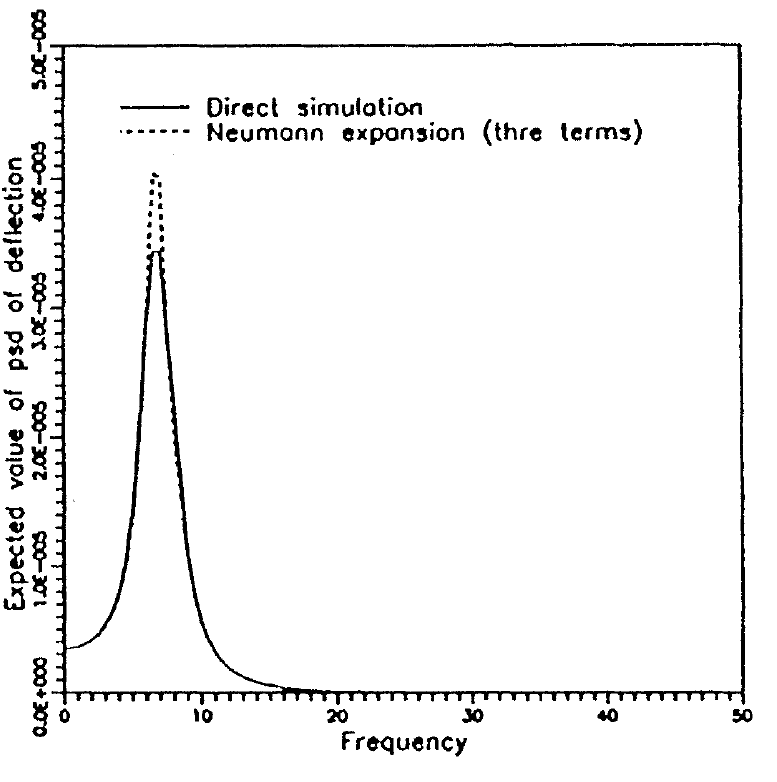
Fig. 5. Expected value of the psd of deflection at node 46 of the plate (c.o.v. =